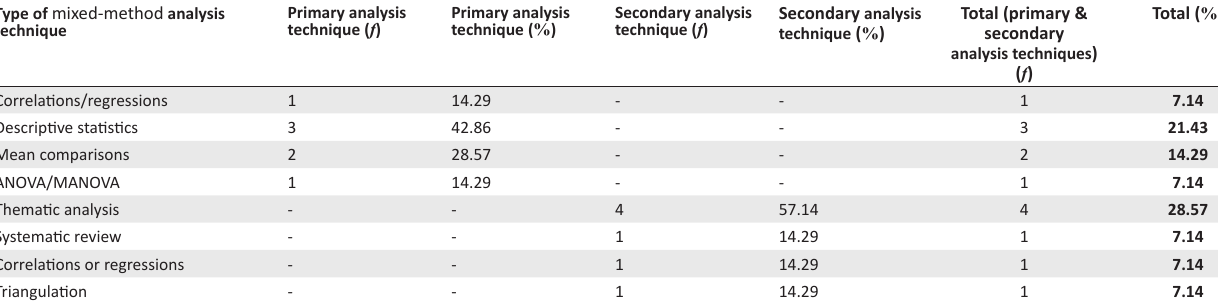
TABLE 10: Mixed-method analysis techniques.